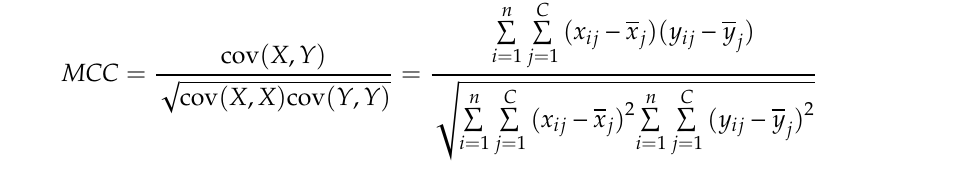
s1. Table S1. The features ranked by their RI values derived from the MCFS method, Table S2. Produced 69 classification rules for classifying samples from the 8 cancer types, Table S3. Corresponding accuracies of individual classes, overall accuracies, and MCCs by using di ff erent numbers of features selected by using the IFS method and SVM